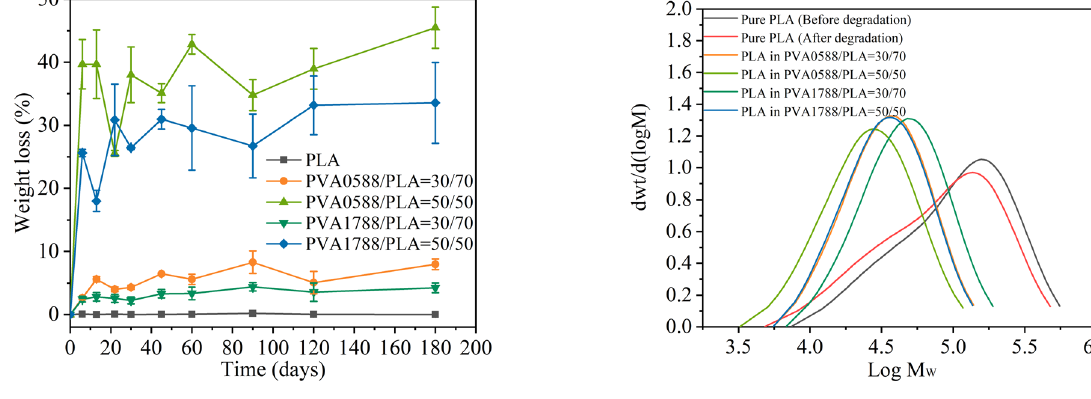
Figure 5: The percentage of weight loss of PLA and PVA/PLA blends in natural seawater over time.